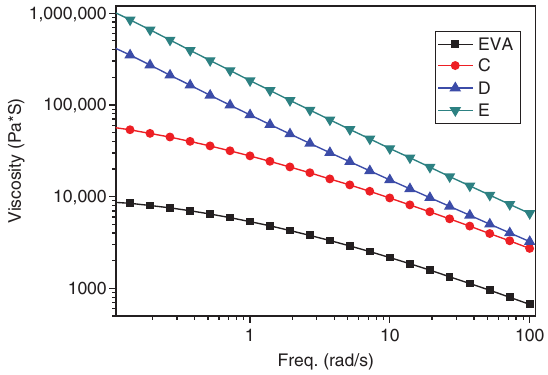
Figure 2: Complex viscosity as a function of frequency at 140 ° C for EVA, samples C, D and E.